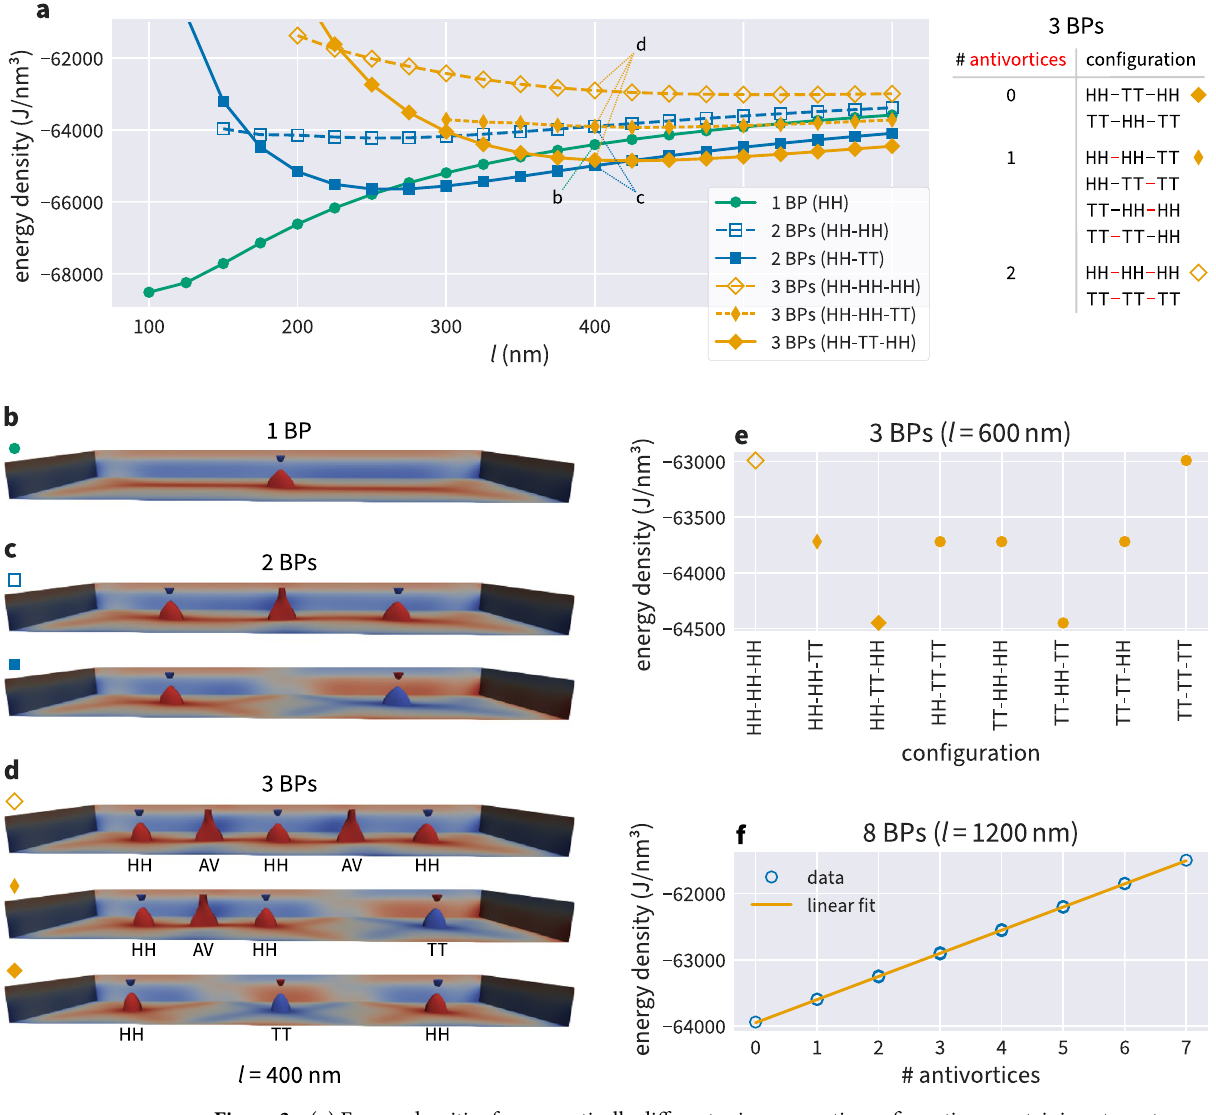
Figure 3. ( a ) Energy densities for energetically different micromagnetic configurations containing at most three Bloch points for different strip lengths l at a strip width w = 100 nm . Simulations have been performed in steps of δ l = 25nm , the solid lines are shown to guide the eye. ( b – d ) Magnetisation profiles for the six different configurations shown in ( a ) at l = 400 nm . Isosurfaces show m z = ± 0.9 , colour indicates the z-component. ( e ) Energy density for all possible configurations containing three Bloch points. The first three configurations are show in ( d ) as indicated with the distinct marker symbols (at a different strip length). The table in ( a ) lists all different configuration containing three Bloch points, highlighting the number and position of the additional antivortices in the different configurations. ( f ) Energy densities for all configurations containing eight Bloch points. Energy densities for a fixed number of antivortices are nearly identical but cause some “smearing” of the marker